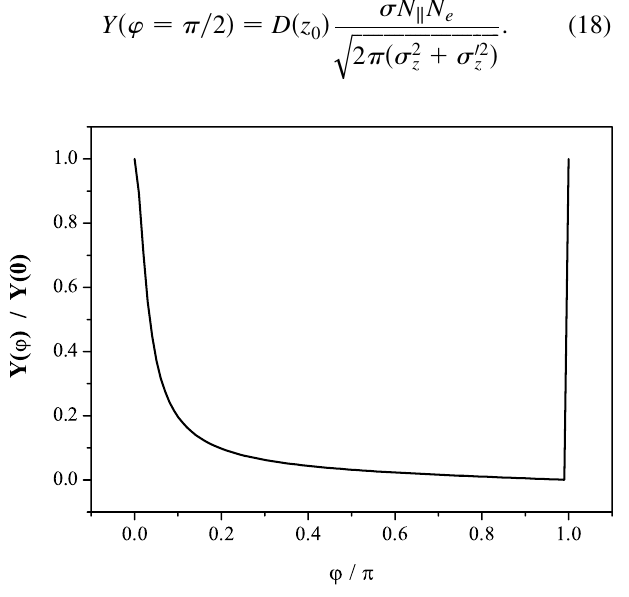
FIG. 3. Total yield versus collision angle Y (cid:2) 0 (cid:3) (cid:1) 280 .